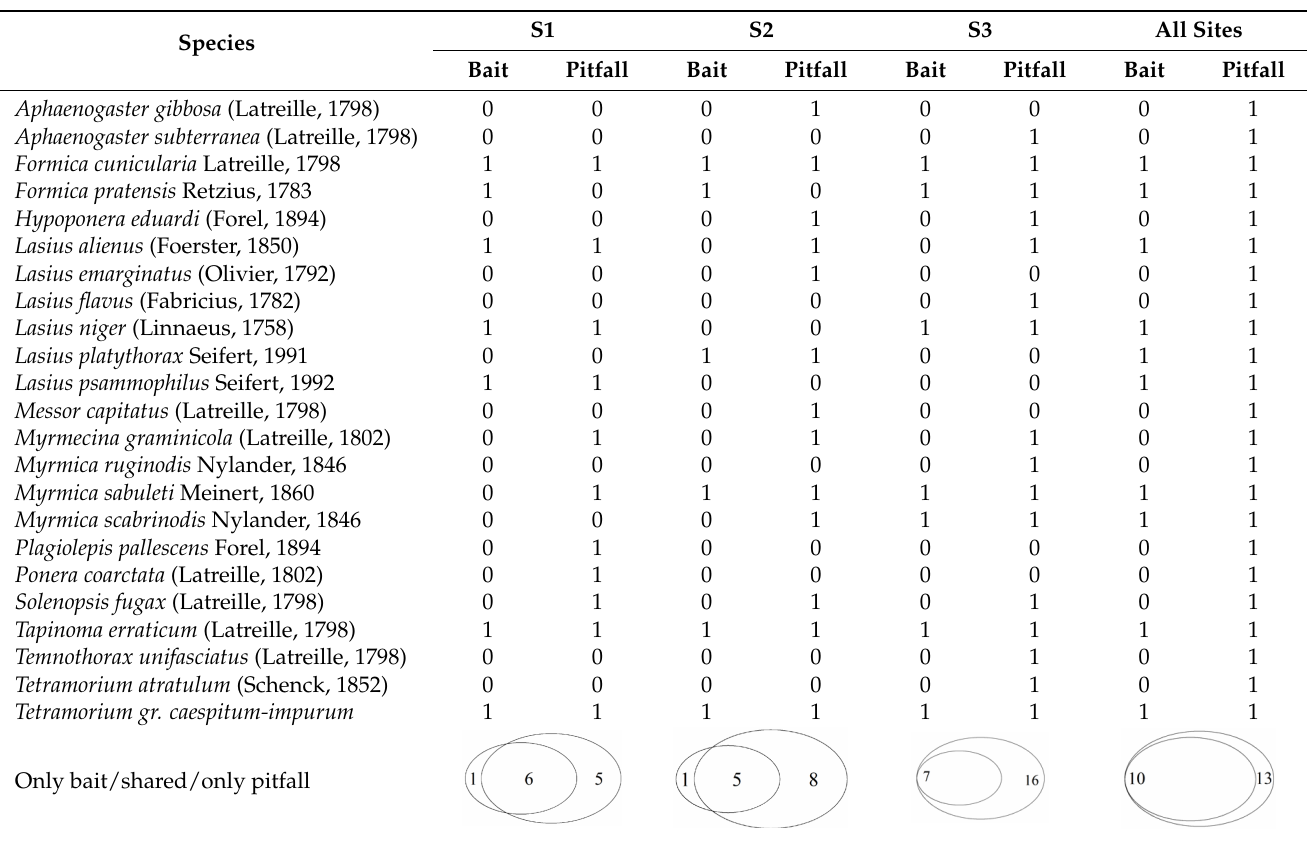
Table 1. Occurrence of ant species in the three sites (S1; S2; S3) for both bait and pitfall traps. S1 S2 S3 All Sites Species Bait Pitfall Bait Pitfall Bait Pitfall Bait